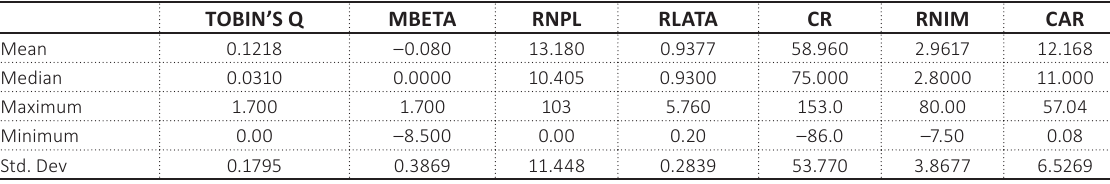
Table 4. Goodness of fit